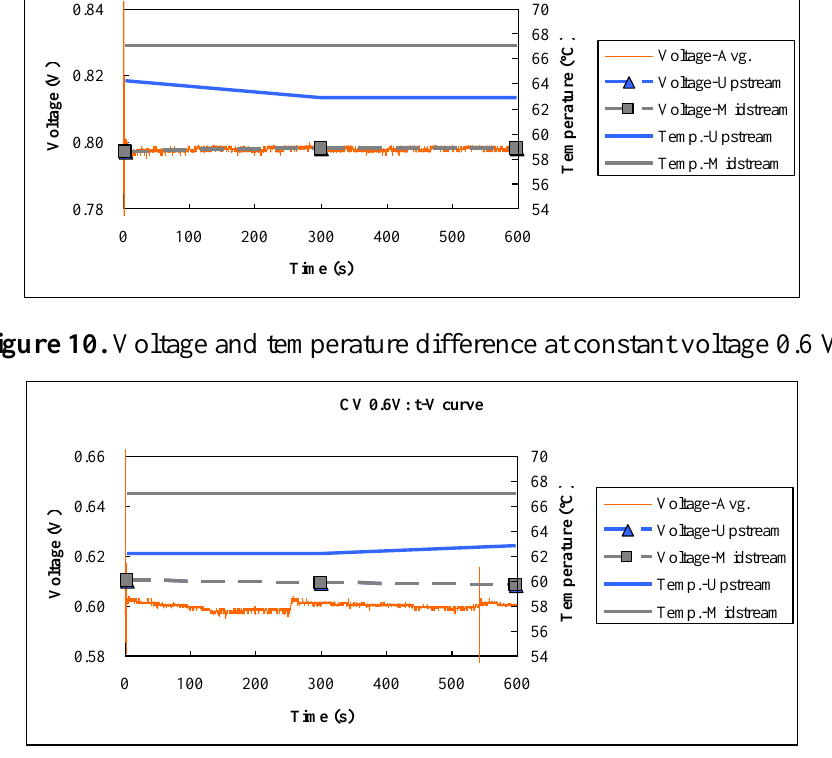
Figure 11. Voltage and temperature difference at constant voltage 0.4 V. CV 0.4V: t-V